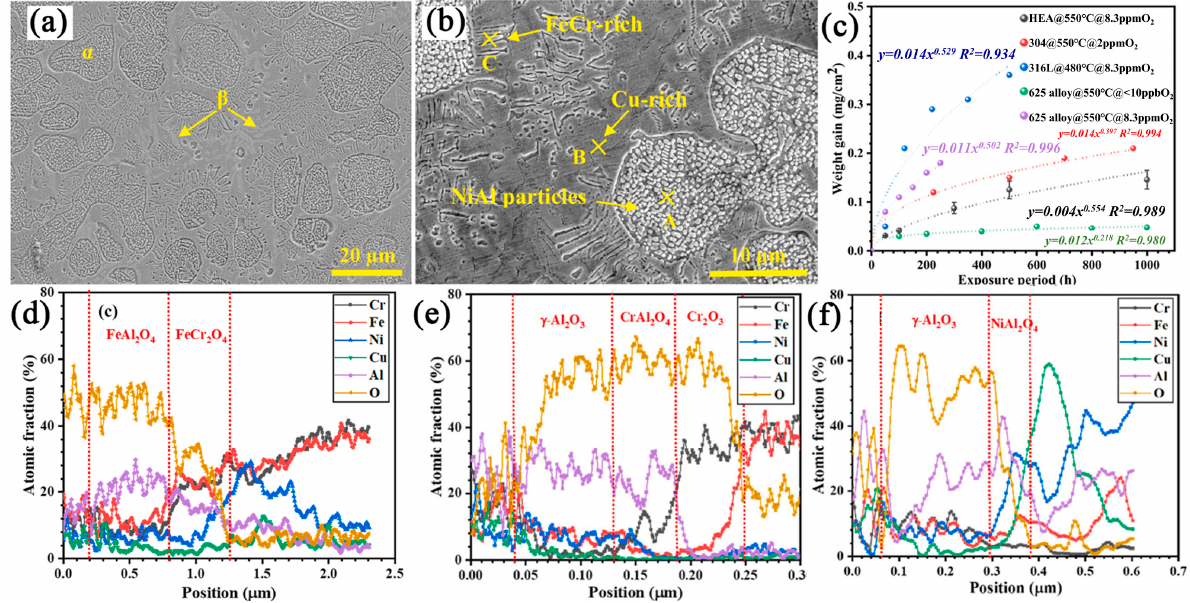
Figure 15. SEM morphologies of the FeNiCrCuAl HEA: ( a ) low magnification image, ( b ) high magnification image, and the yellow arrows show the phase distribution; ( c ) the weight gain curves vs. exposure period at 550 °C and 25 MPa in SCW for different materials; the line-scanning elemental distribution of the oxide films ( d ) upon the FeCr-rich BCC phase after being immersed at 550 °C and 25 MPa for 100 h, ( e ) upon the FeCr-rich BCC phase after being immersed at 550 °C and 25 MPa for 1000 h, and ( f ) upon the NiAl-rich phase after being immersed at 550 °C and 25 MPa for 100 h, the dotted lines represent the boundary of the different layers. [101].